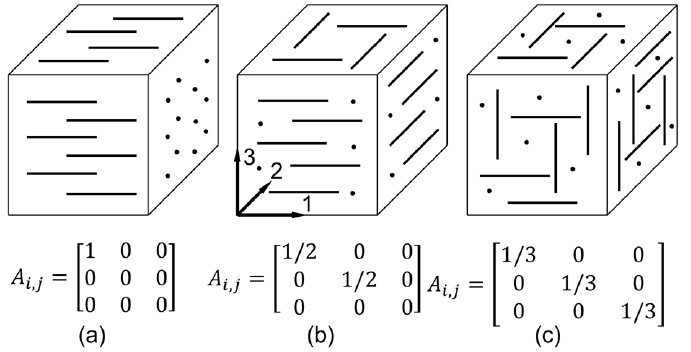
Figure 1. Explanation of fibre orientation tensor, based on [14,15] ( a ) oriented in direction 1, ( b ) planar isotropy in plane 1-2, ( c ) isotropic.